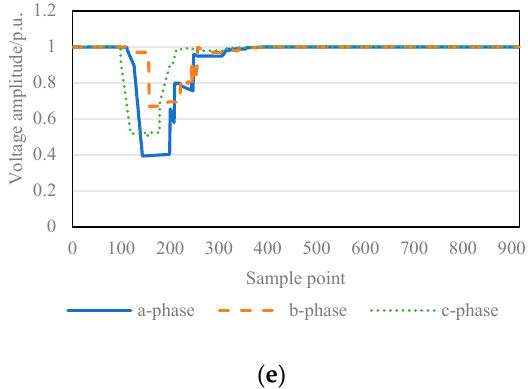
Figure 1. Comparison chart of different types of sag signals. ( a ) Voltage sag is caused by a single- phase grounding fault; ( b ) voltage sag is caused by a two-phase grounding fault; ( c ) voltage sag is caused by a three-phase grounding fault; ( d ) voltage sag is caused by induction motor starting; ( e ) voltage sag is caused by transformer switching.